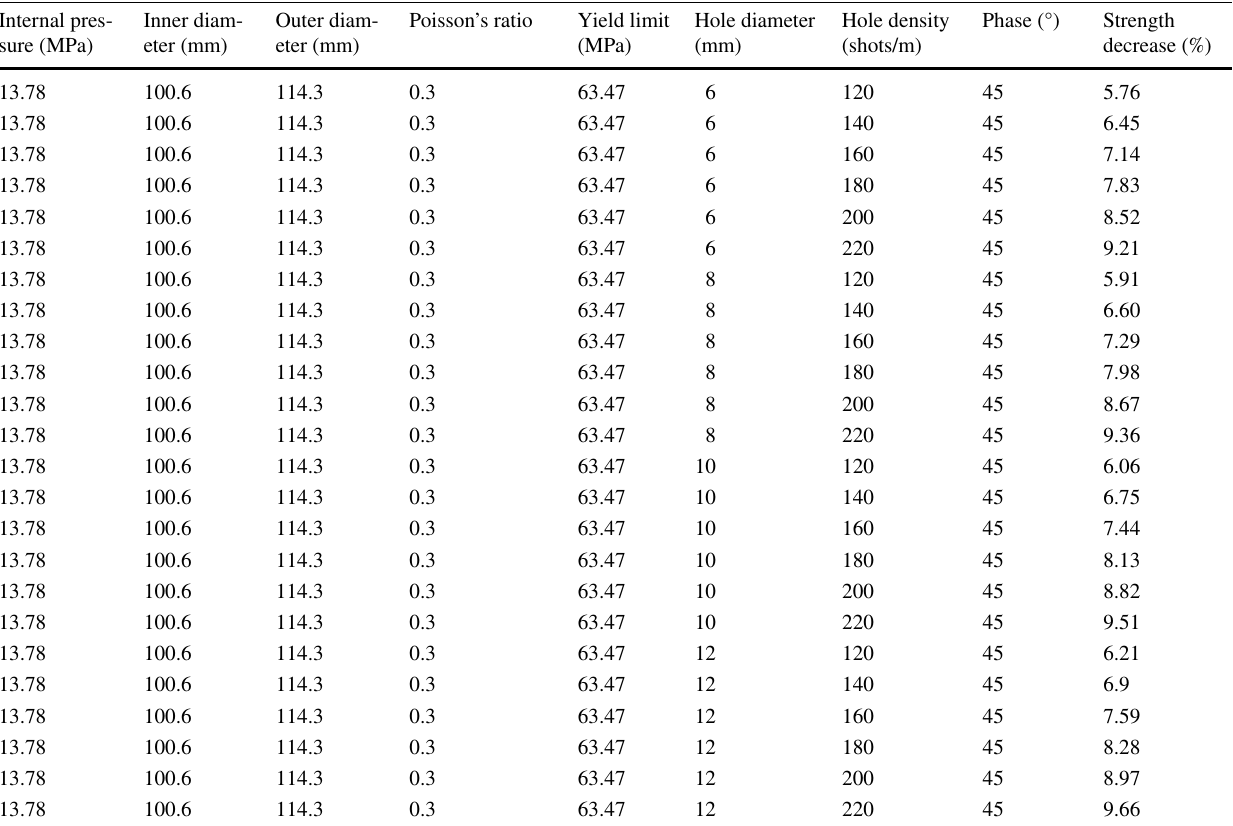
Table 4 Collapse resistance strength of casing after perforated Internal pres- sure (MPa)